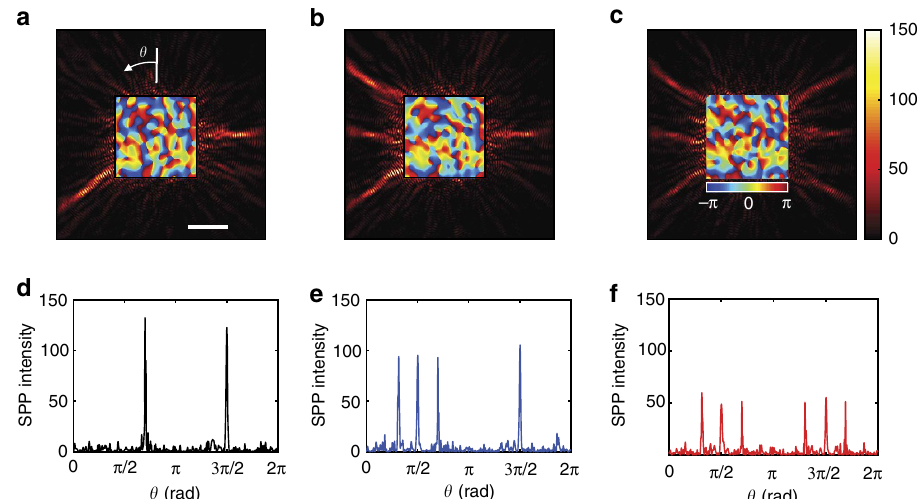
Figure 5 | Experimental demonstration of a MIMO network using the focusing of SPPs at multiple spots. ( a – c ) SPP maps after focusing at two, four and six spots, respectively. Vertical colour bar: intensity of the SPPs in an arbitrary unit. The square colour maps at the centre of the images indicate the phase maps of the far-field illumination incident to the pattern of nanoholes. Horizontal colour bar: phase in radians. Scale bar, 5 m m. ( d – f ) The intensity of SPPs along the sampling line with respect to the angle y indicated in ( a ) for the cases of ( a – c )